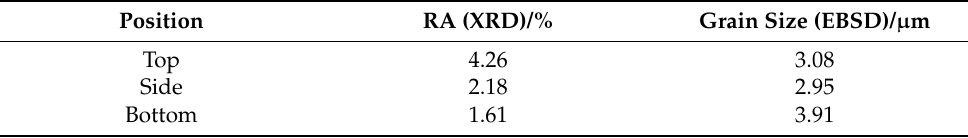
Figure 8. X-ray diffraction (XRD) spectra of hot-formed parts in different positions: ( a ) top; ( b ) side; and ( c ) bottom. Table 4. Volume fractions of RA and grain size for hot-formed parts in different positions.